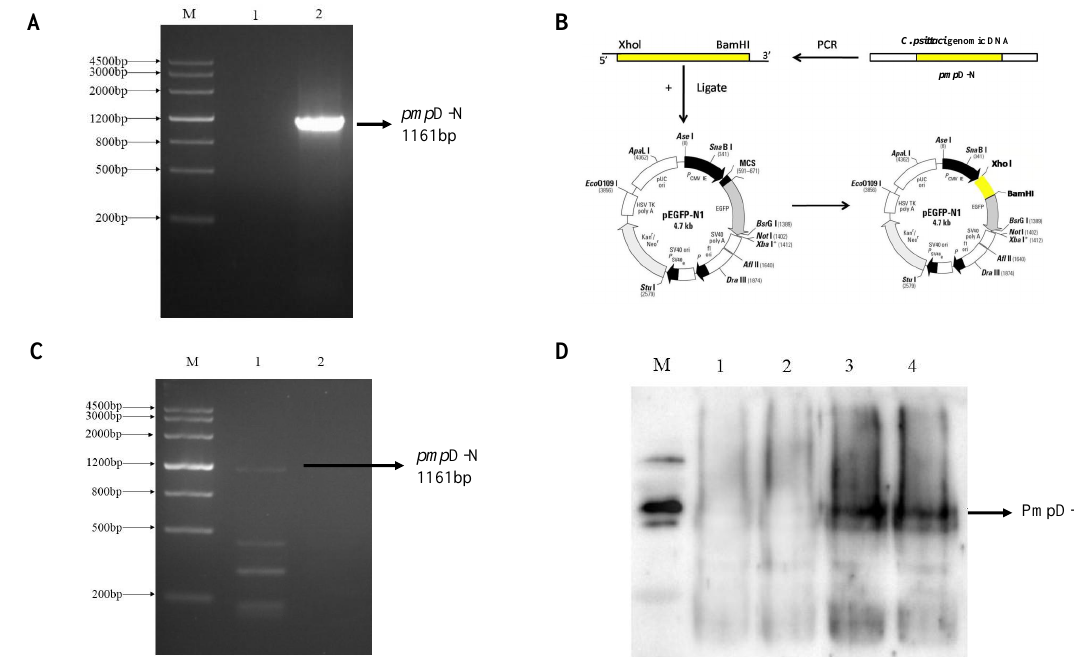
Figure 1. Construction of pEGFP-N1- pmp D-N plasmid and detection of PmpD-N expression. ( A )